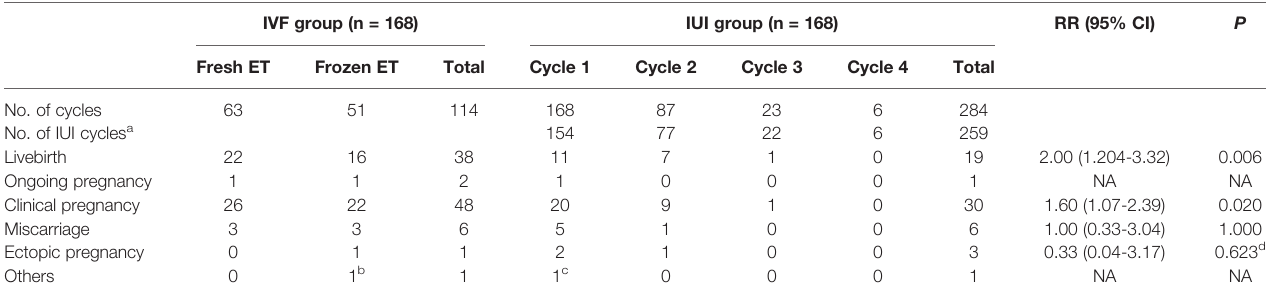
TABLE 4 | Pregnancy outcomes of the IUI and IVF/ICSI patients after